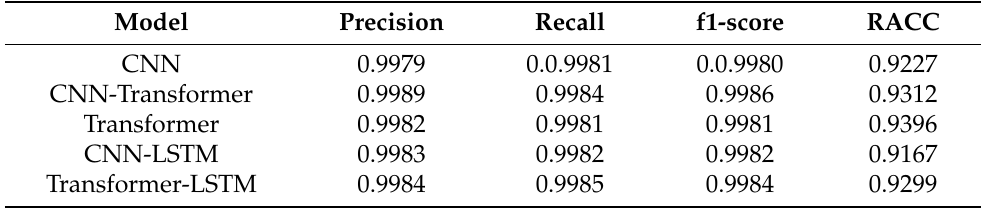
Table 7. Performance comparison for detecting the location of FDI in IEEE-14 bus